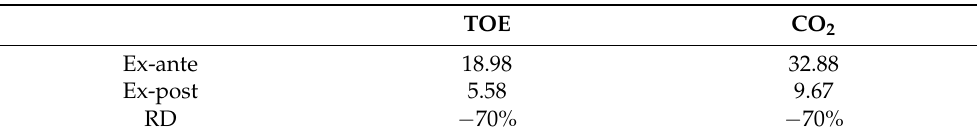
Table 11. Tons of oil equivalent (TOE) and tons of annual carbon dioxide (CO 2 ) of the ex-ante and ex-post installations.